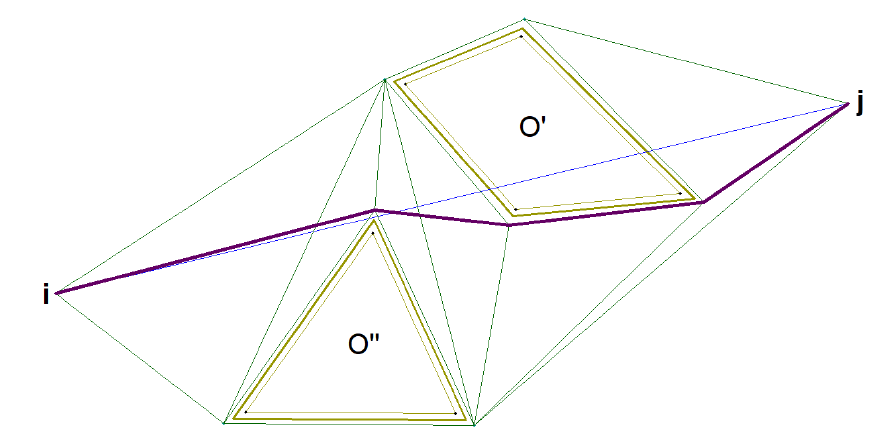
Figure 6. Result of an obstacle avoidance algorithm.